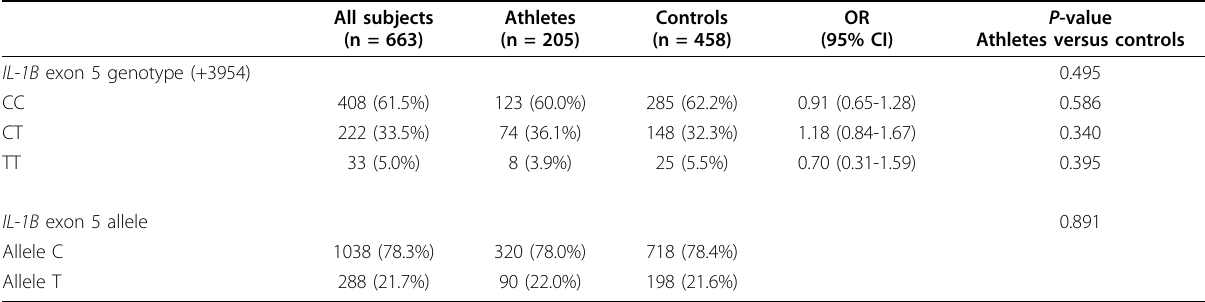
Table 3 Genotype frequencies of IL-1B exon 5 at position +3954 in 663 subjects, comparison of 205 athletes and 458 non-athlete controls